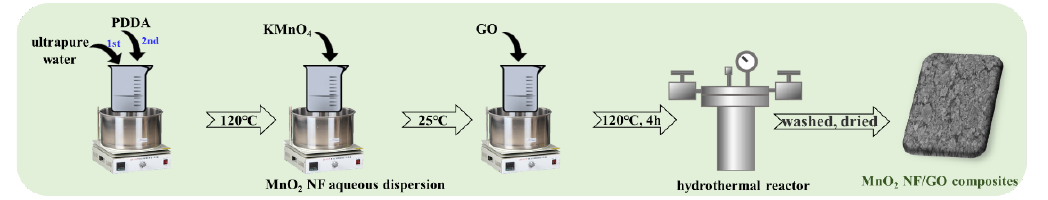
Figure 6. Fabrication of MnO 2 NF/GO composites.